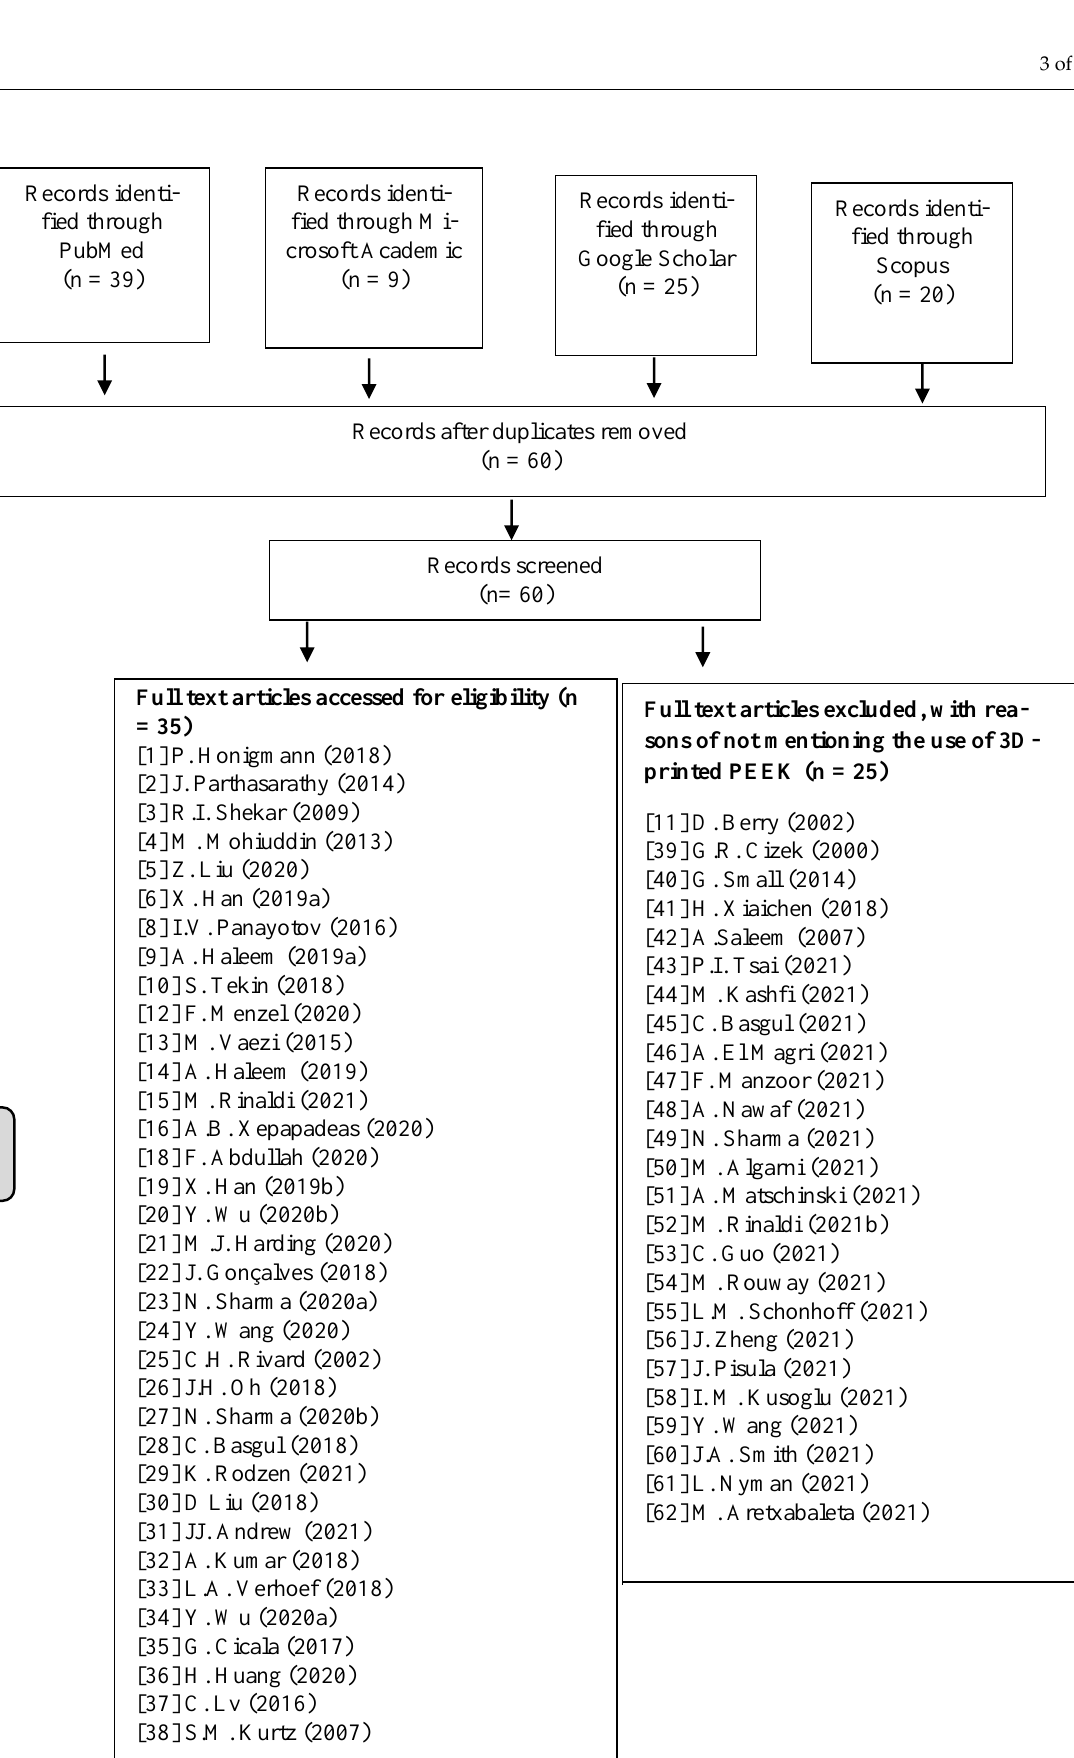
Figure 1. Flow diagram of the different stages of the systematic review.